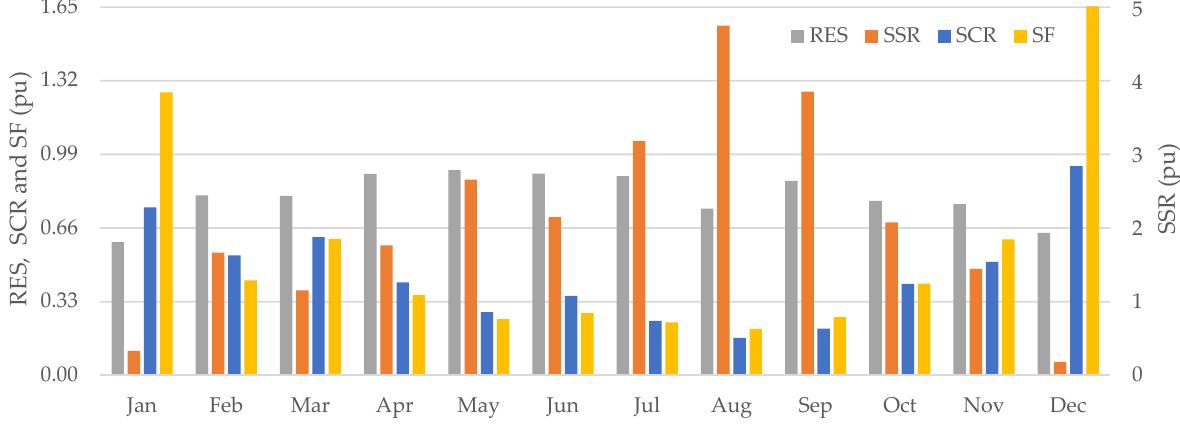
Figure 15. Monthly average daily mean system-level KPIs.